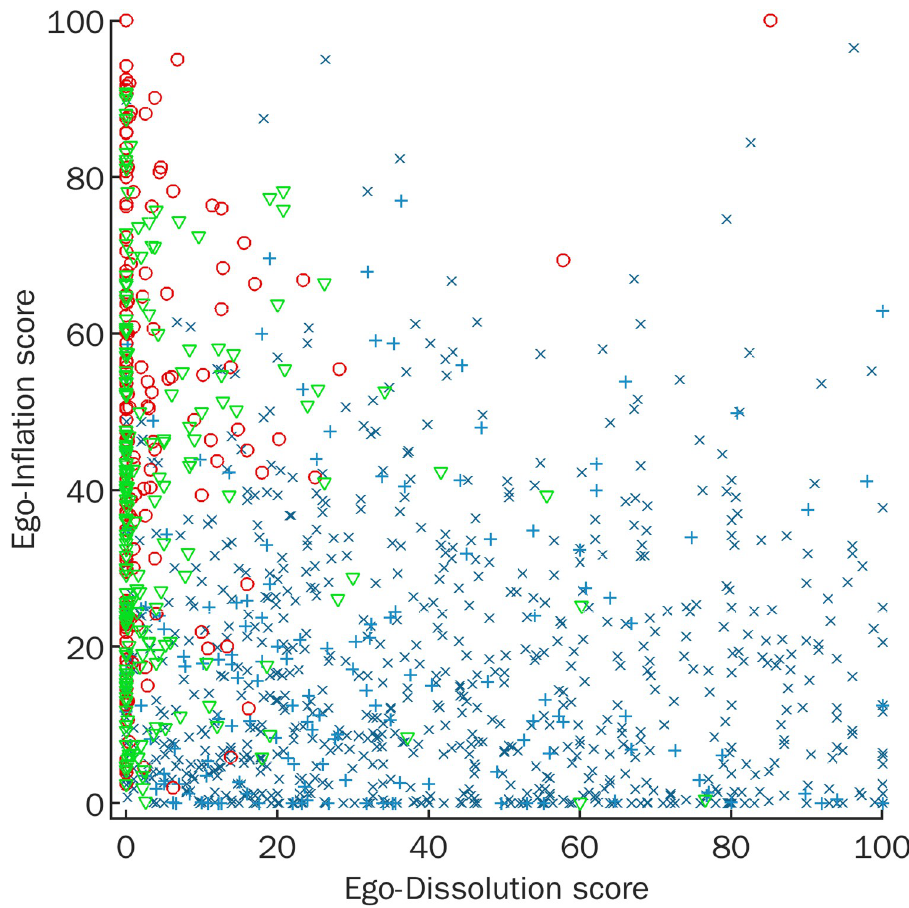
Fig 4. Relationship between ego-dissolution and ego-inflation for different drug experiences. Mean scores of EDI- 5 and EII items were used as a measure of ego-dissolution and ego-inflation, respectively, and plotted for intense hallucinogen experiences (blue crosses), typical hallucinogen experiences (light blue plus signs), cocaine experiences (red circles), and alcohol experiences (green triangles)